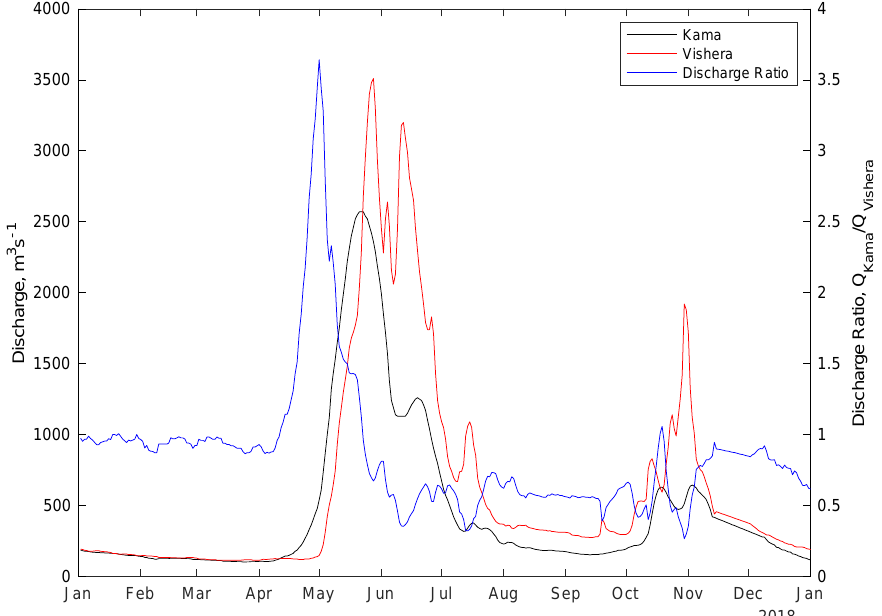
Figure 1. Time-series of discharges in the Kama and Vishera rivers and the associated discharge ratios.